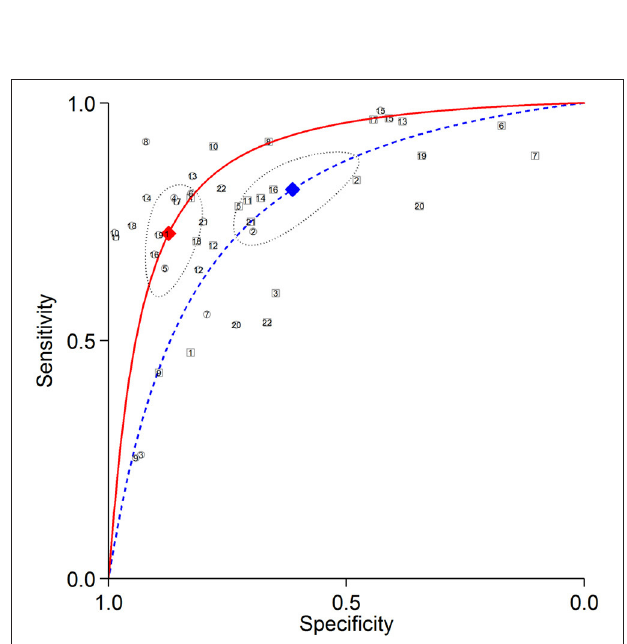
FIGURE 3 | Summary ROC curves of detecting LAD stenosis. Comparisons of summary ROC curves between all AC (solid line) vs. all NAC (dashed line). Each circle (AC) and square (NAC) represent an individual included study. Diamonds represent summary operating points of pooled sensitivity and specificity. AC, attenuation correction; CAD, coronary artery disease; LAD, left anterior descending artery; NAC, non-AC; ROC, receiver operating characteristic.